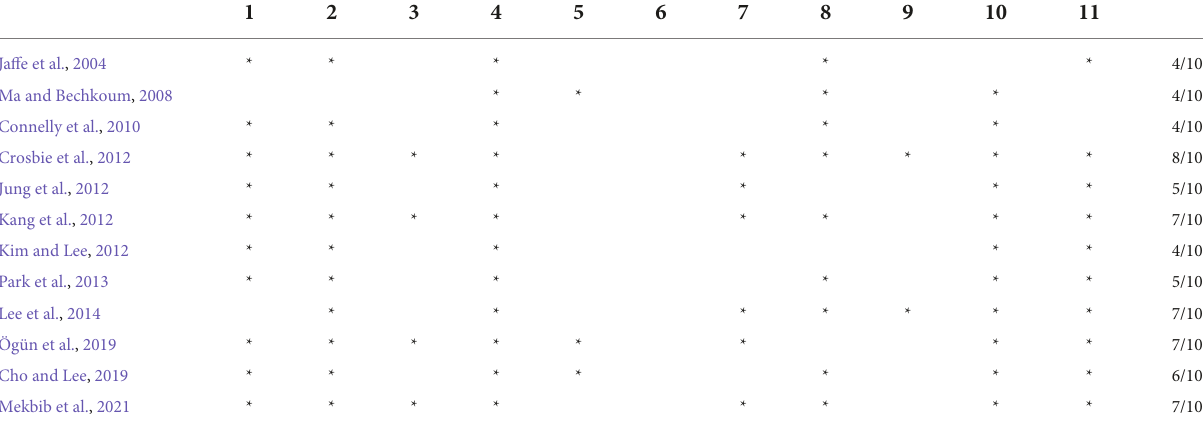
TABLE 2 Quality of the RCT studies of stroke patients on PEDro Scale (item 1 does not contribute to total